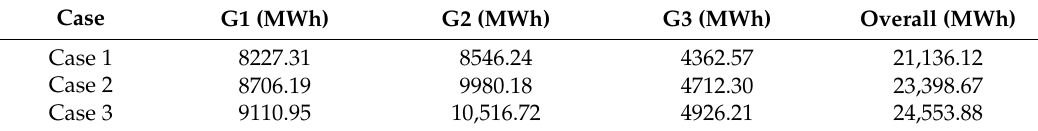
Figure 6. ( a ) Purchased power from G1; ( b ) Purchased power from G2; ( c ) Purchased power from